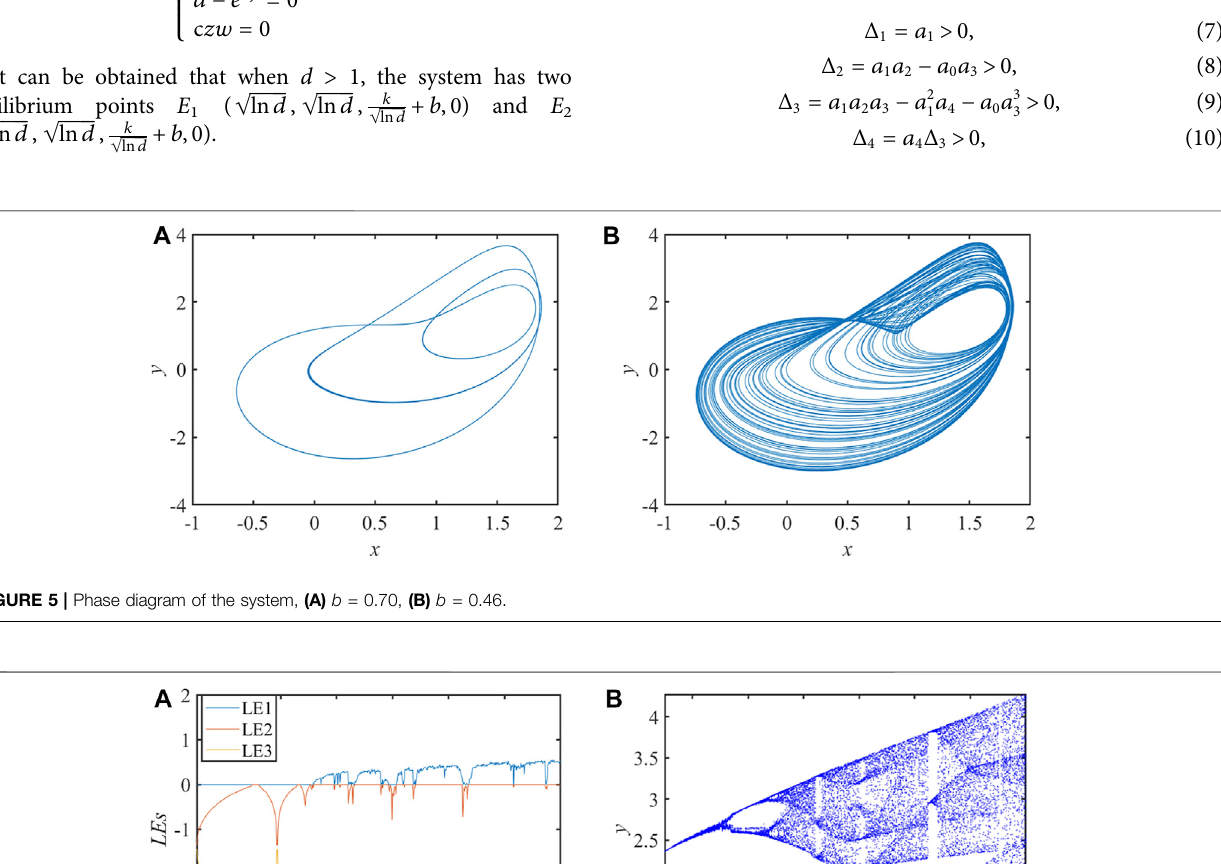
Frontiers in Physics |